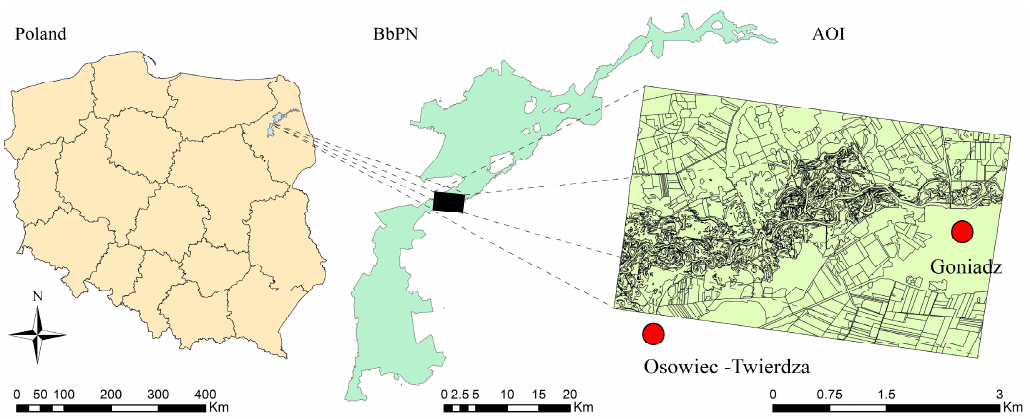
Figure 1. Location of the study area in Northeastern Poland.